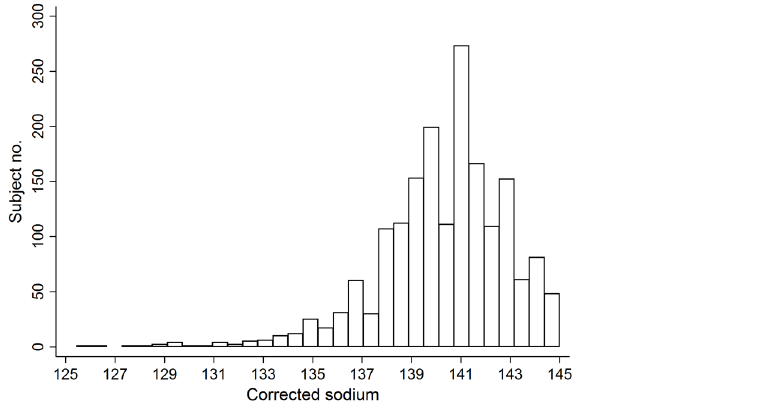
Fig 1. A histogram of the corrected sodium levels.